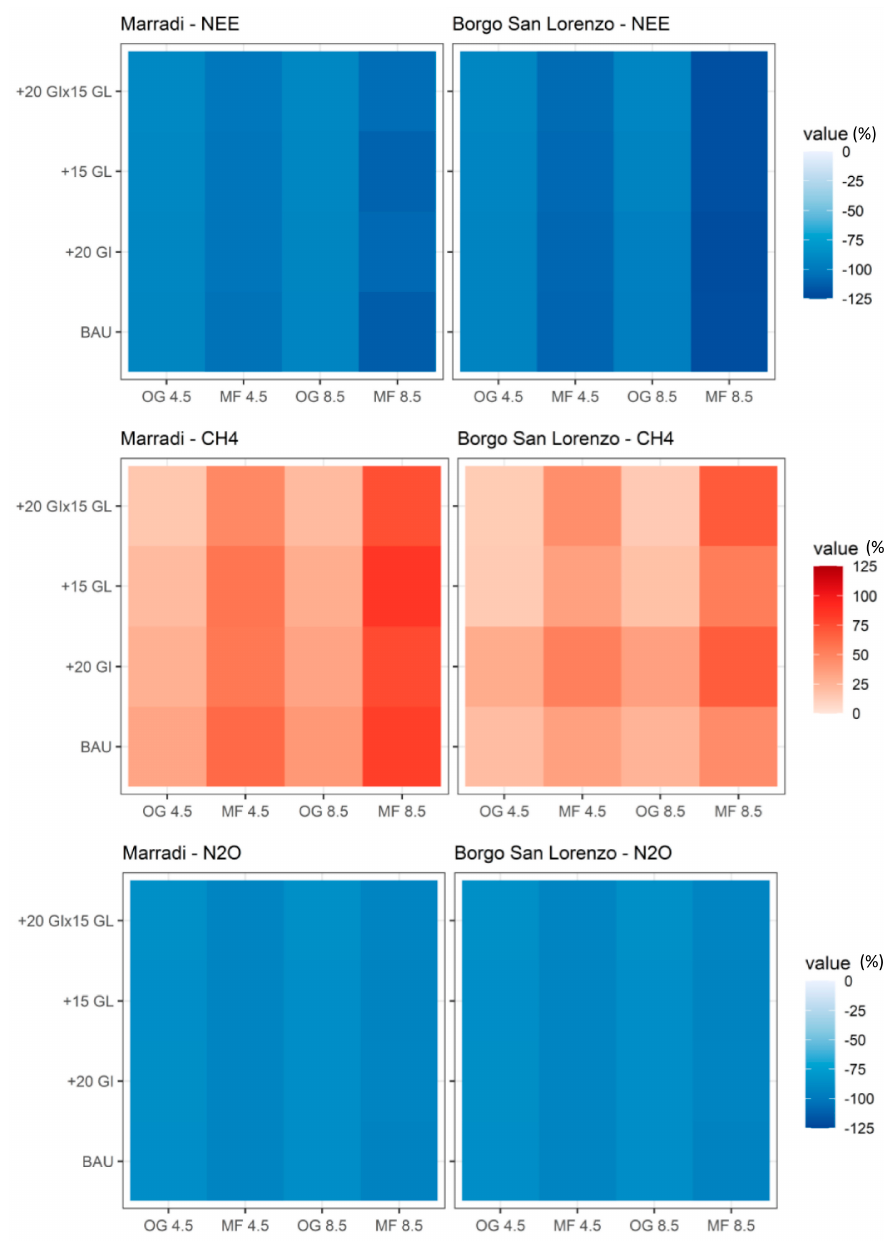
Figure 9. Heatmap visualization of the relative differences (%) of the three main greenhouse gas emissions (NEE: net ecosystem exchange; CH 4 : methane; and N 2 O: nitrous oxide), estimated using PaSim, for alternative management and climate change scenarios compared with current climate and management in the two study sites. OG: ongoing period, MF: mid-future period, 4.5: RCP4.5, 8.5: RCP8.5, GI: grazing intensity; and GL: grazing length, 20: +20%, 15: +15%. As for CH 4 emissions, the PaSim heatmap indicates that emissions are higher